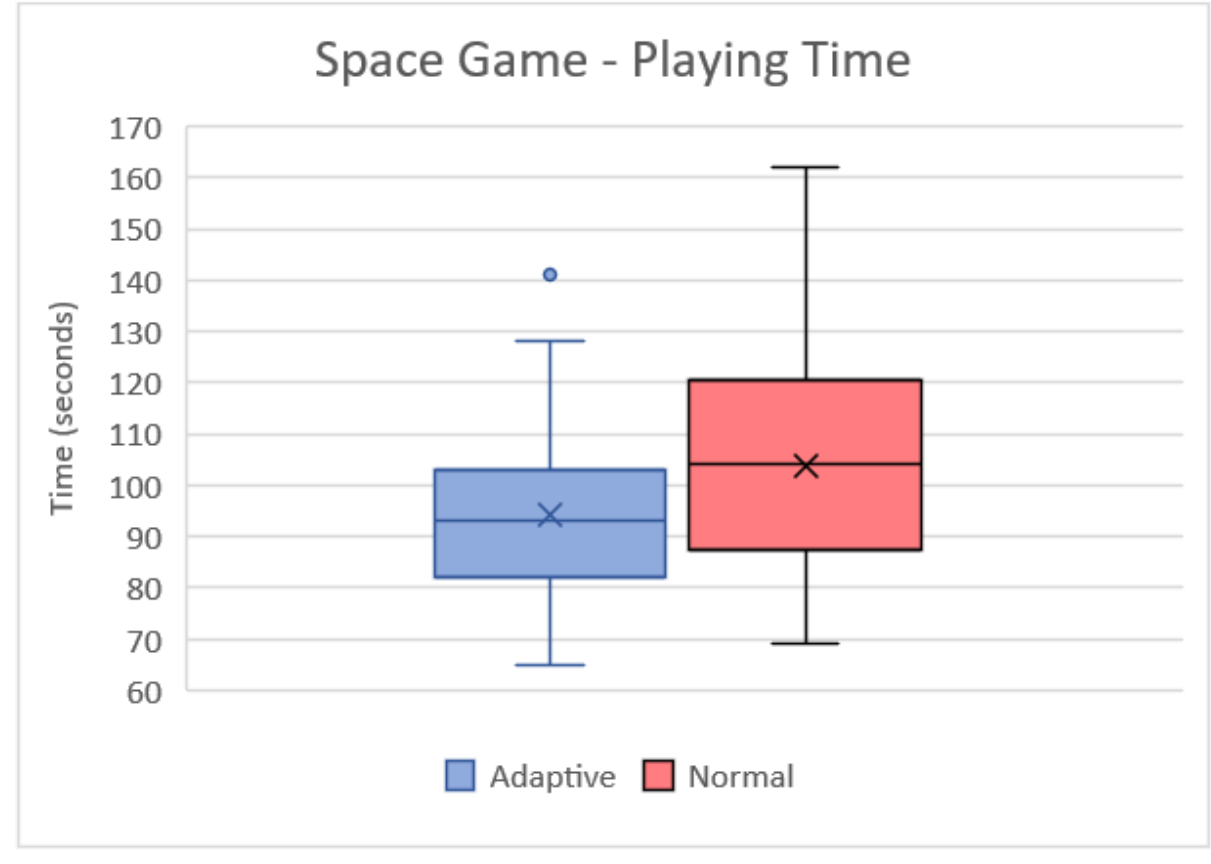
Figure 8. Box plot of playing time for the Space game from the second session with students.